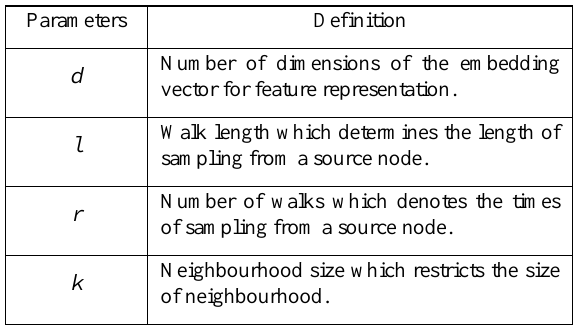
Table 1. Global parameters involved in the biased random walk: Setting them to higher values would help obtain a more accurate clustering